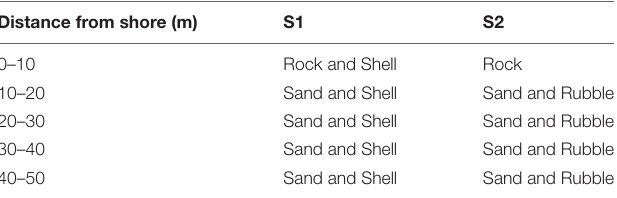
rock and shell substrata characterised the seabed at DS < 10